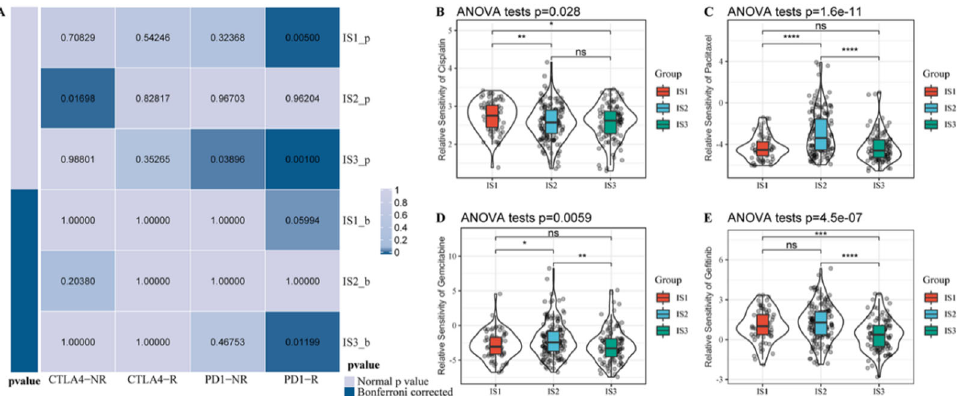
Figure 6. Association between immune subtypes and immunotherapy/chemotherapy response. ( A ). Submap analysis showing that IS3 is potentially more sensitive to PD-1 inhibitors. Bonferroni adjusted p -values less than 0.05 were considered statistically significant. B-E. Box plots of the estimated IC50 values for cisplatin ( B ), paclitaxel ( C ), gemcitabine ( D ), and gefitinib ( E ). * p < 0.05; ** p < 0.01; *** p < 0.001; **** p < 0.0001, and ns, no significance.